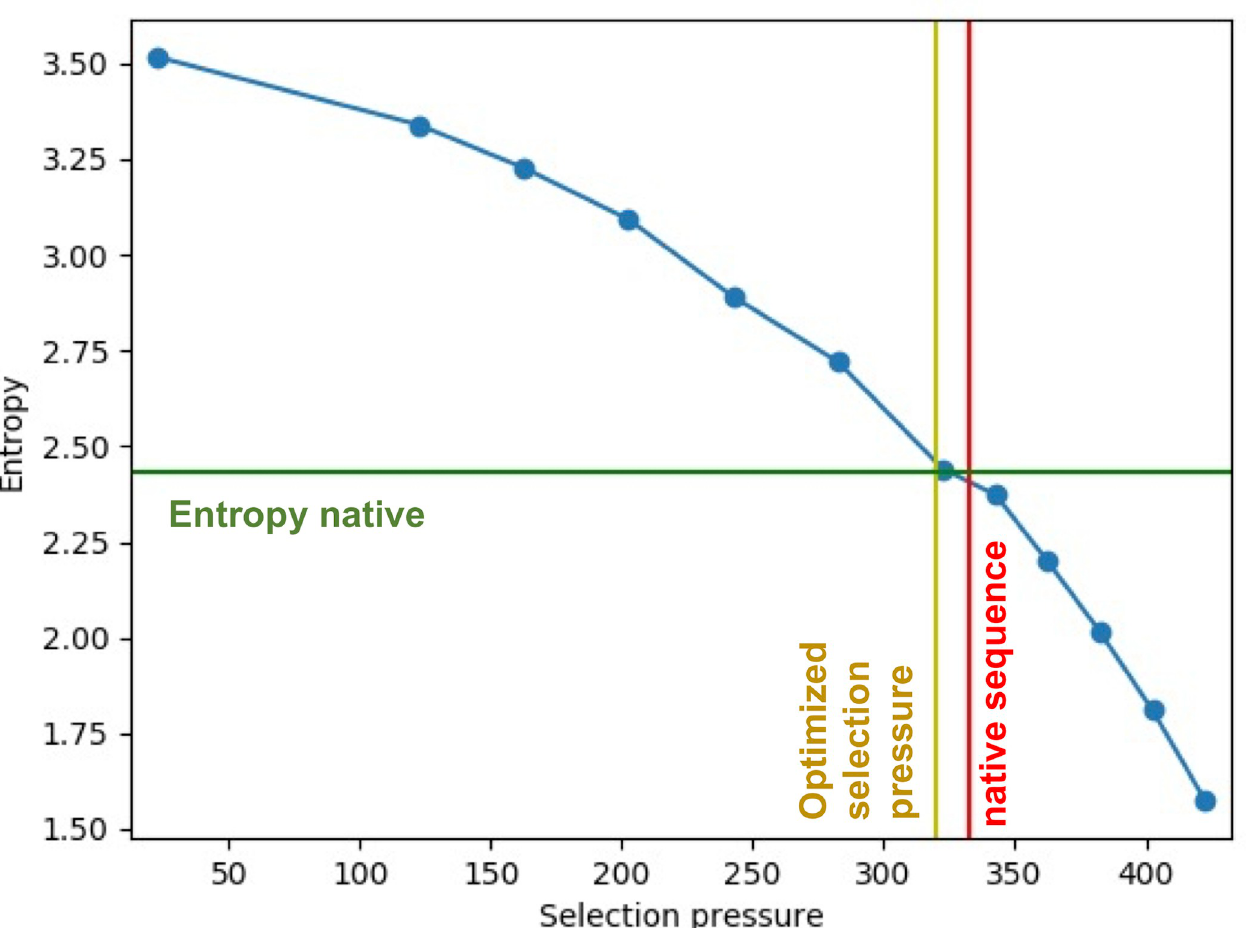
Fig 4. Simulation of phylogenetic trees of azurin with RosettaEvolve. Dependence of sequence entropy of leaf sequences with reference energies. The green line corresponds to the entropy in the natural sequences used to infer the azurin tree. The red line corresponds to the energy of the native sequence of azurin. The yellow line corresponds to the selection pressure that maximizes the correlation between computed and empirical amino acid substitution rates in Norn et al. [7].